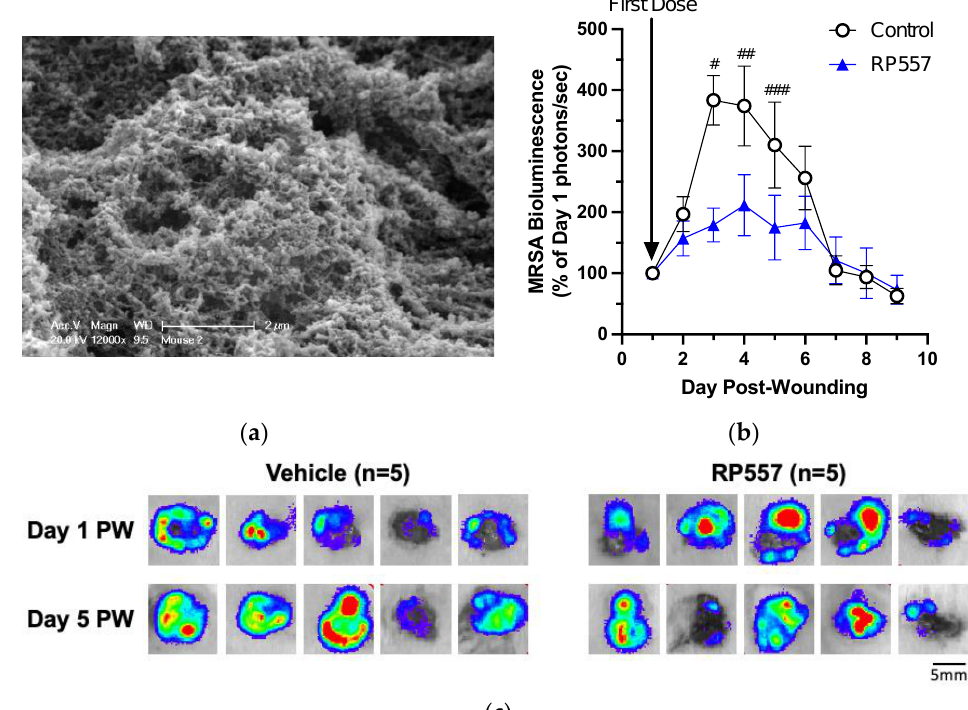
Figure 4. Effect of RP557 on bacteria killing against S. aureus in diabetic mouse wounds. TALLYHO diabetic mice were dorsally wounded and subdermally infected with bioluminescent MRSA USA300 (Day 0). Starting at one day after infection, mouse wounds were treated daily with either saline (control) or RP557. ( a ) SEM scan of the wound environment at 24 h post-infection showing that MRSA proliferated and formed a biofilm. ( b ) Wound bioluminescence was measured in an IVIS as photons/second and normalized to their value on Day 1. ( c ) Representative bioluminescence IVIS scans at one and five days after wounding. Data are from two independent experiments. n = 5 – 10 animals per group. #, ##, and ### denote p -values of <0.001, <0.070, and <0.150, respectively. Scale bar is 5mm.